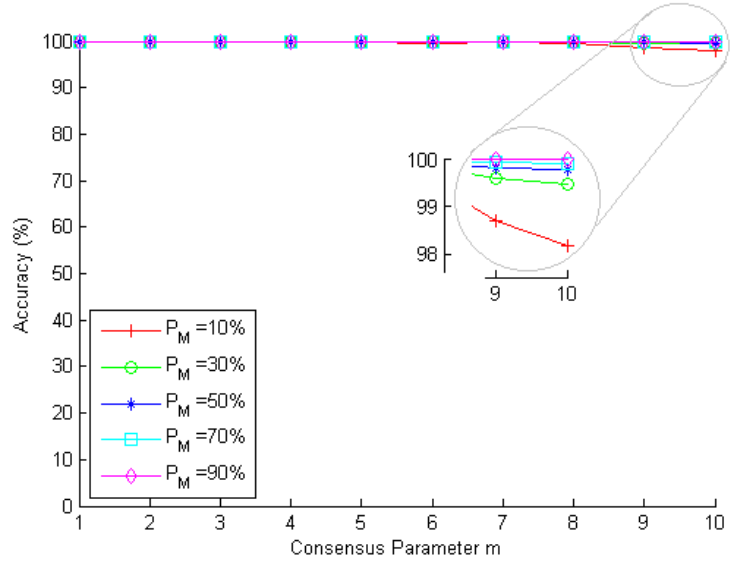
Figure 7. Accuracy of the legitimacy probability when the IDS raises a global alarm, P ( alarm ) , vs. consensus parameter m . For different values of P L P = 0 . 6 and P = 0 . 4 tp fp